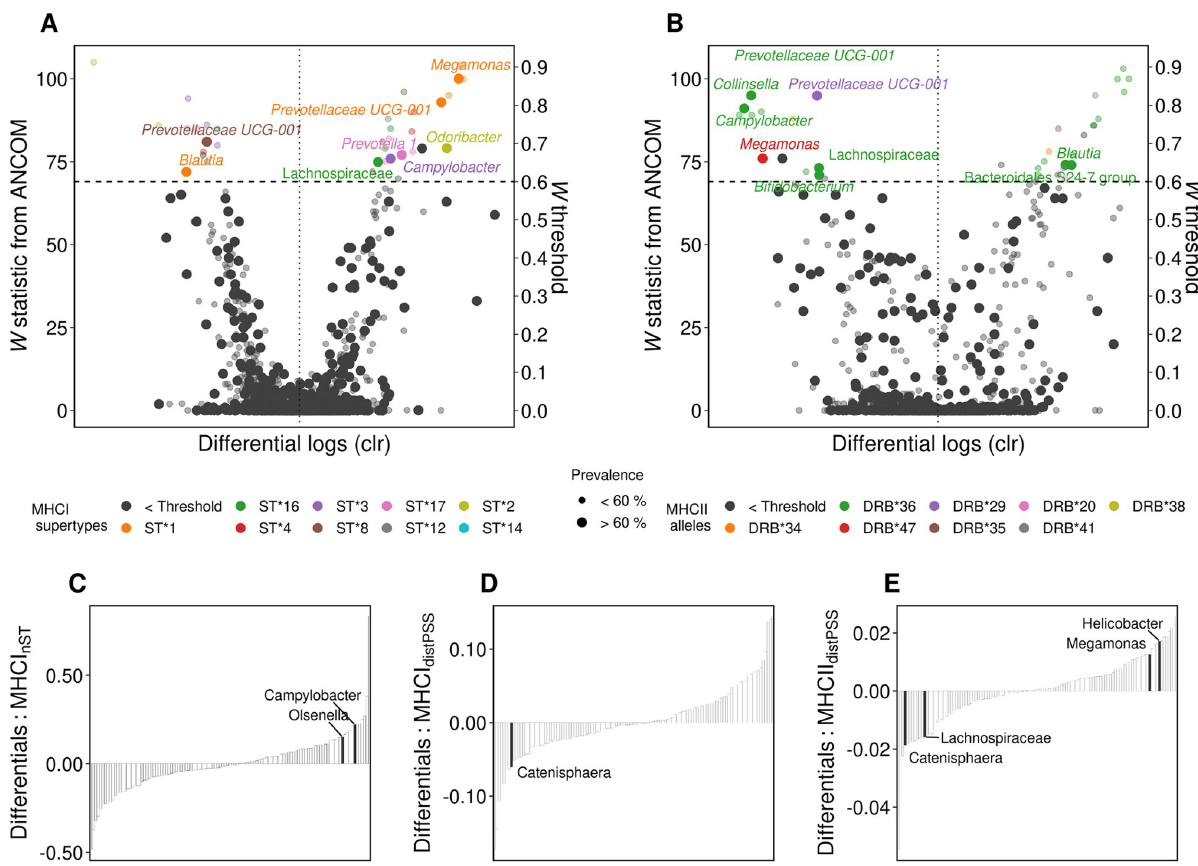
Fig 3. MHC diversity is associated with shifts in microbiome composition. (A-B) Association between specific MHCI supertypes and MHCII alleles and microbial taxa (n = 143). Significance threshold is informed by W statistic (horizontal dashed line) and F estimates (vertical dotted line). ASV’s above this threshold represent taxa significantly ( P < 0.005) associated with a specific MHC motif. Taxa are colored according to their association with a MHC motif. Labels are shown for core taxa (prevalence > 60%). (C-E) Microbial ranks based on multinomial regression coefficients sorted by